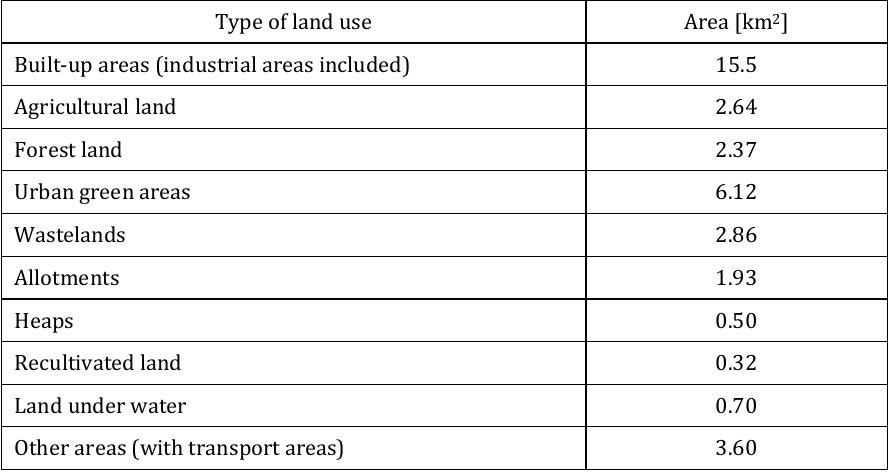
Table 1. Spatial structure of the city Chorzów (Aglomeracja śląska w liczbach, 2006) Type of land use Area [km 2